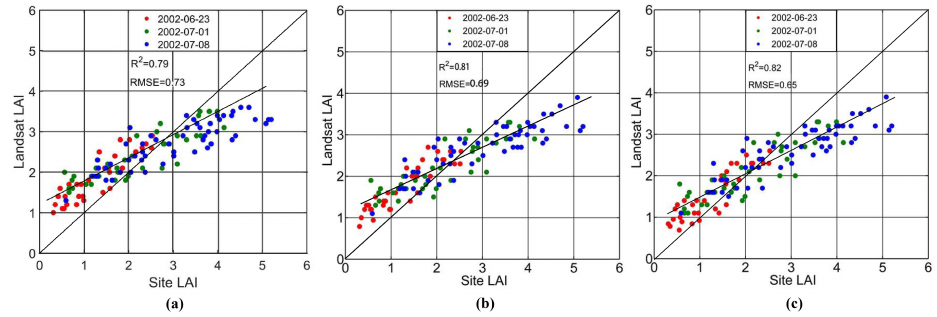
Figure 5. The comparison between the retrieved LAI by three approaches and field measurements: ( a ) the results of dataset A1 (upscaled Landsat reflectance at the 500-m resolution and MODIS LAI products); ( b ) the results of dataset A2 (MODIS reflectance and LAI products); ( c ) the results of dataset B (unmixed MODIS surface reflectance and LAI products at 30-m